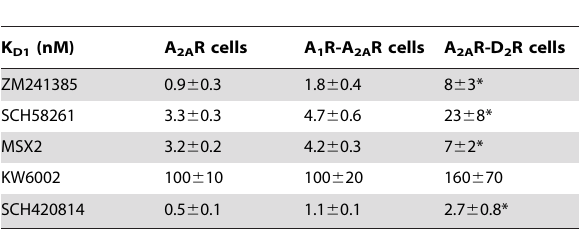
Table 4. Pharmacological parameters for